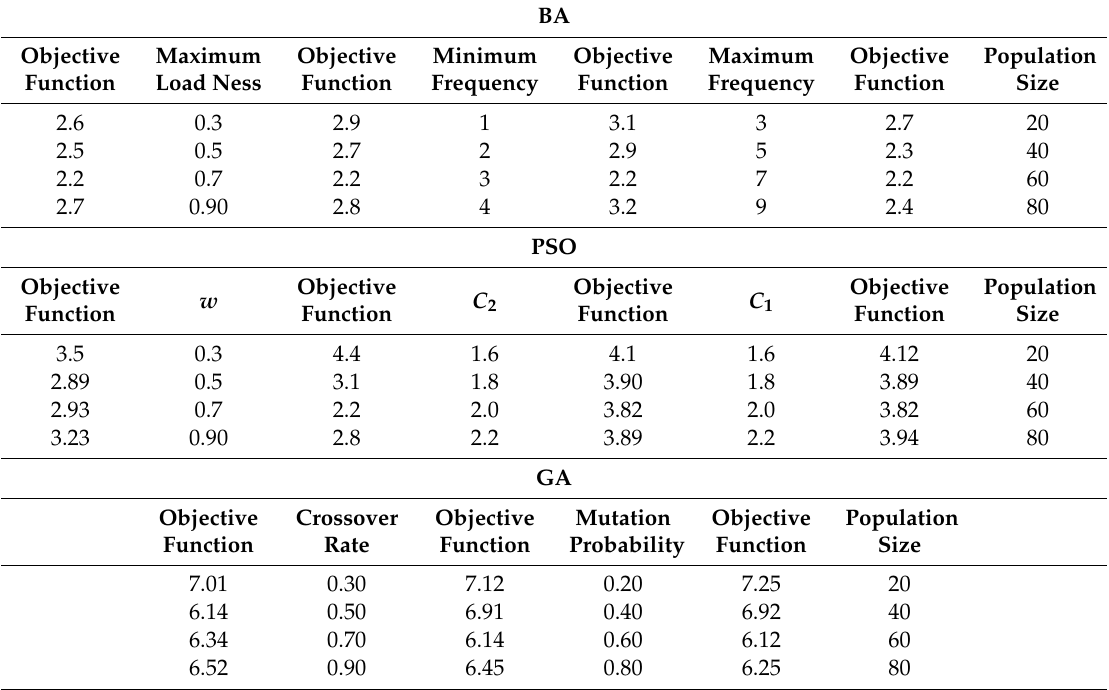
Table 5. Sensitivity analysis for BA, PSO and